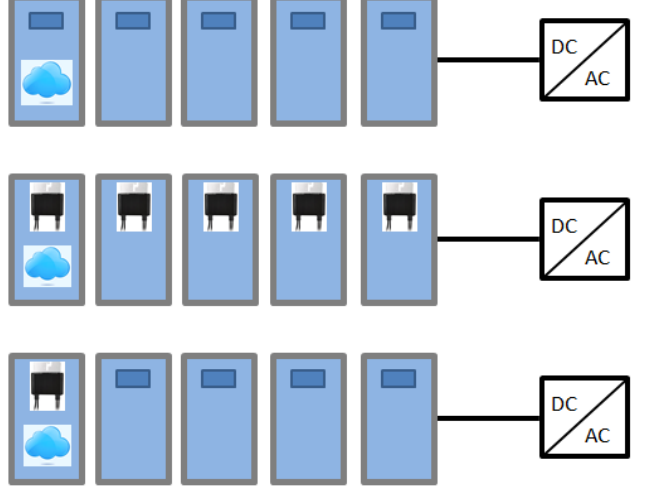
Figure 1. The top displays a string inverter system without any module level power electronics (MLPE), the middle displays a typical power optimizer (PO) system, with optimizers deployed behind each individual solar panel, and the bottom displays selective deployment of a PO in the partially shaded panel